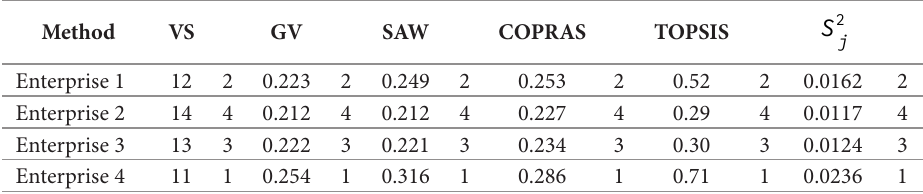
Table 7. Relative estimates of the financial status of four construction